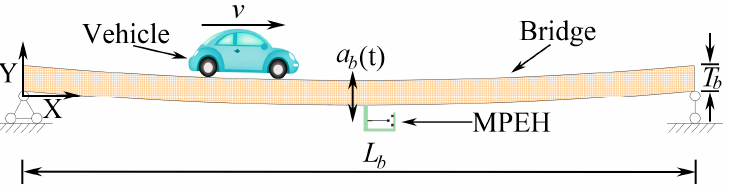
Figure 2. Schematic diagram of energy harvesting from bridge vibration excited by a moving vehi ‐ cle.